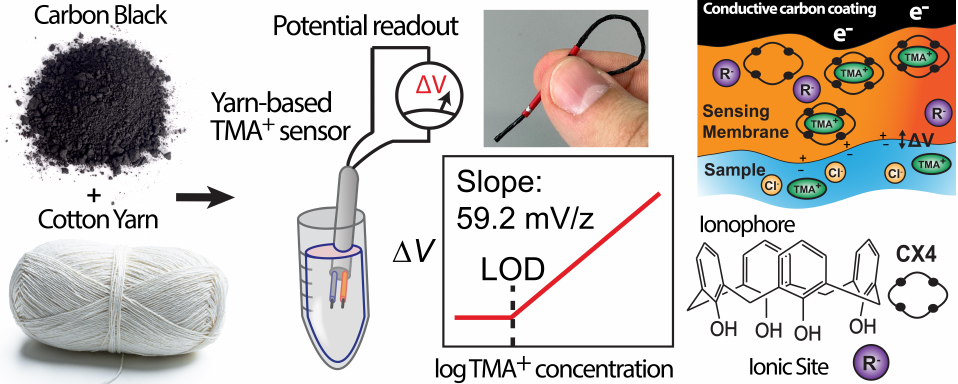
Figure 4. The proposed Home-Based Electrochemical Rapid Sensor, HERS. The sensor is made of carbon black and cotton yarn, and a potentiometric ion-sensing membrane. The electrochemical potential of the HERS depends linearly on the logarithm of TMA + activity in the test solution. A calix[4]arene ionophore selects for TMA + via complex formation in the sensing membrane. The negatively charged ionic site (R − ) buffers the concentration of the TMA + in the sensing membrane and establishes a sample-dependent potential. The charge separation of TMA + and its counter anion at the interface of the sensing membrane and sample solution creates an electrical potential (emf) that is measured by the